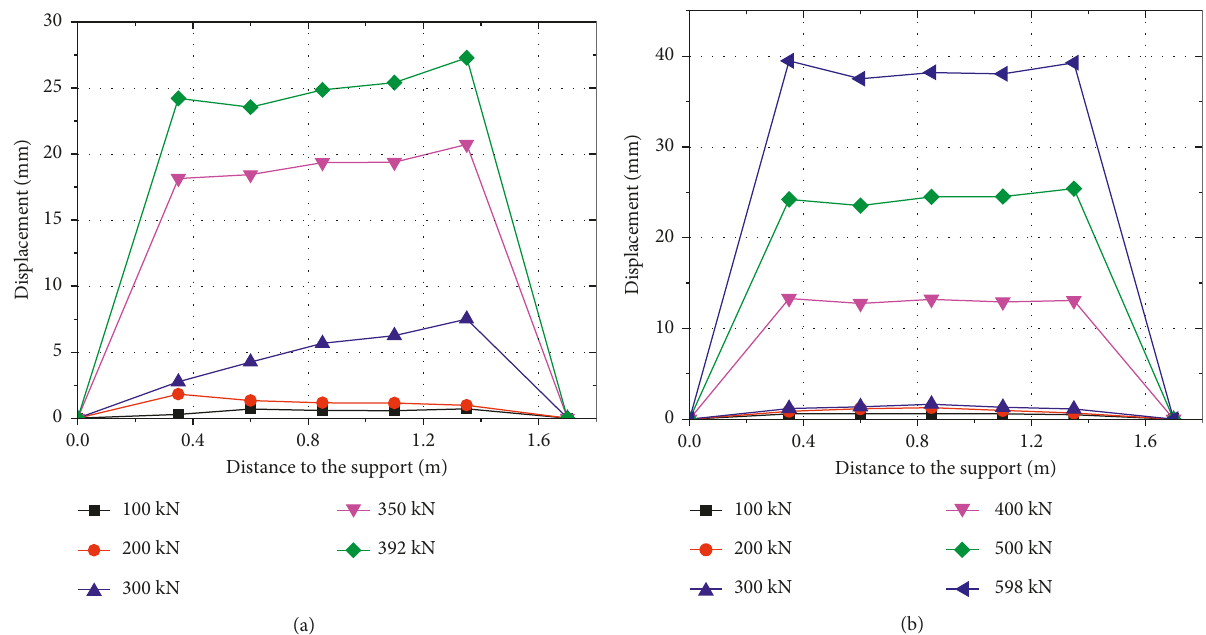
Figure 14: Deflection along the longitudinal direction of the specimens. (a) P1. (b) P2.